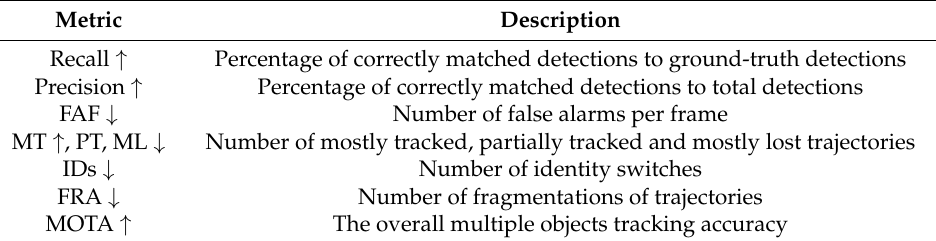
Table 2. The evaluation metrics to assess our